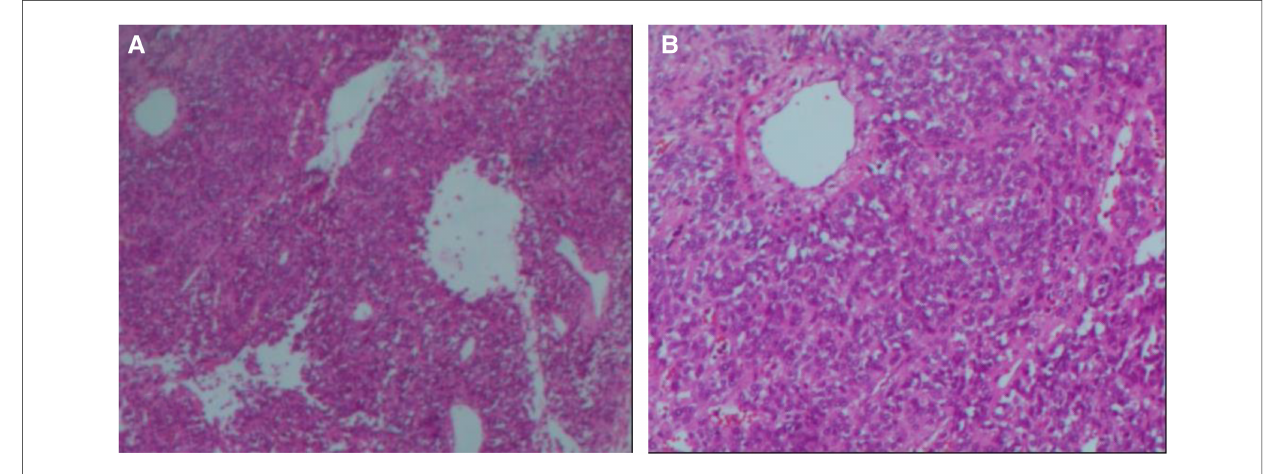
FIGURE 3 Microscopic appearance ( A,B ). Histological magni fi cation revealed that the tumor cells are small and round [hematoxylin and eosin staining,×200 ( A,B